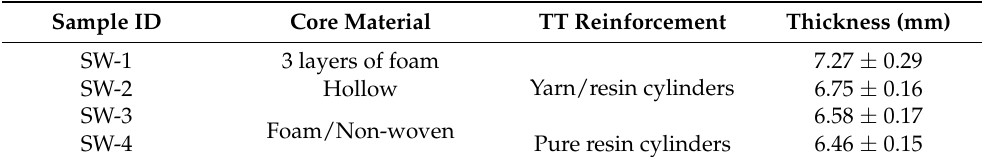
Figure 1. Manufacturing process of the sandwich composite. Table 1. Essential parameters of the samples. Table 1. Essential parameters of the samples.